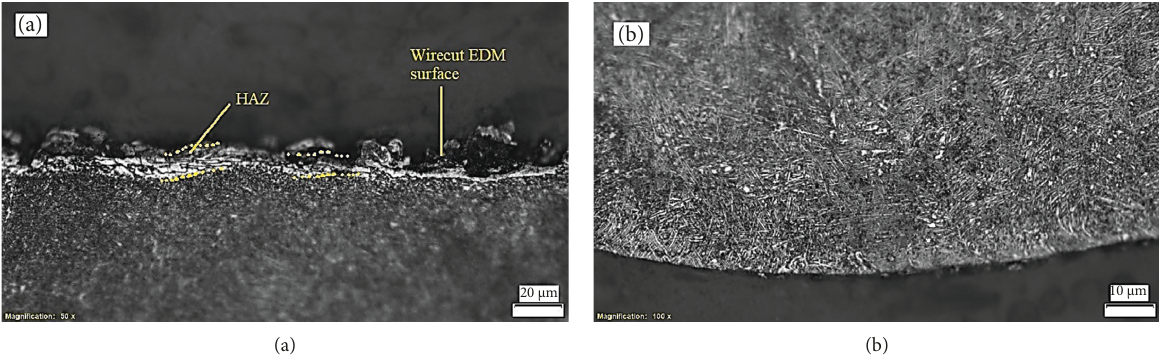
Figure 8: Effect of the support-removal method on the microstructure: (a) wire EDM and (b) manual methods.